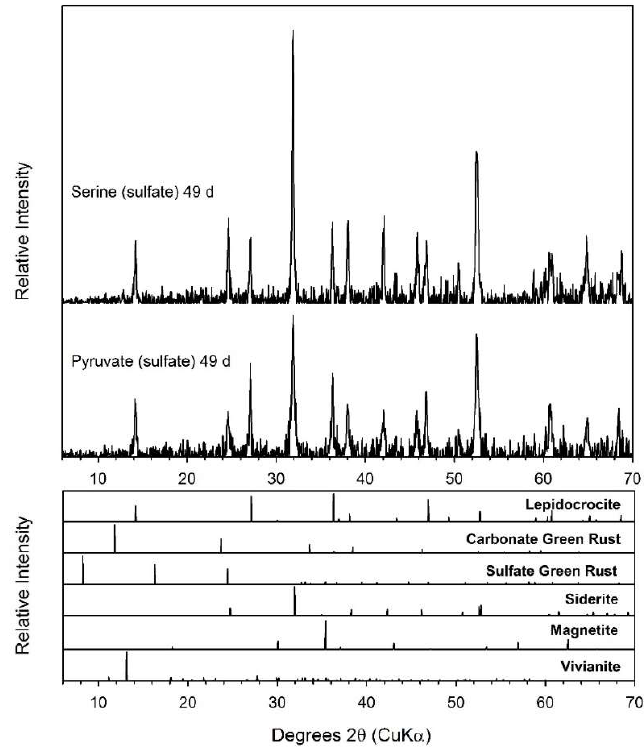
Figure 13. pXRD analysis of the solids in the sulfate-amended systems with pyruvate or serine as the electron donor.